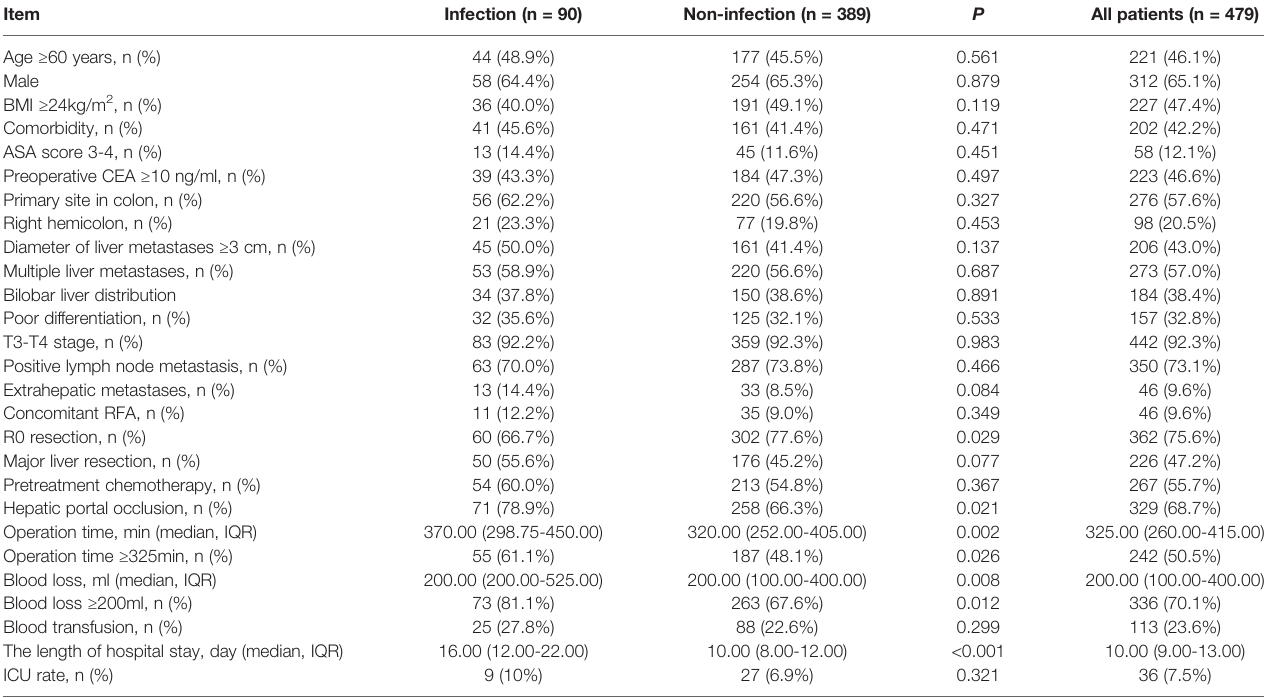
TABLE 1 | Postoperative infectious complications in CRLM patients before PSM (n=479).